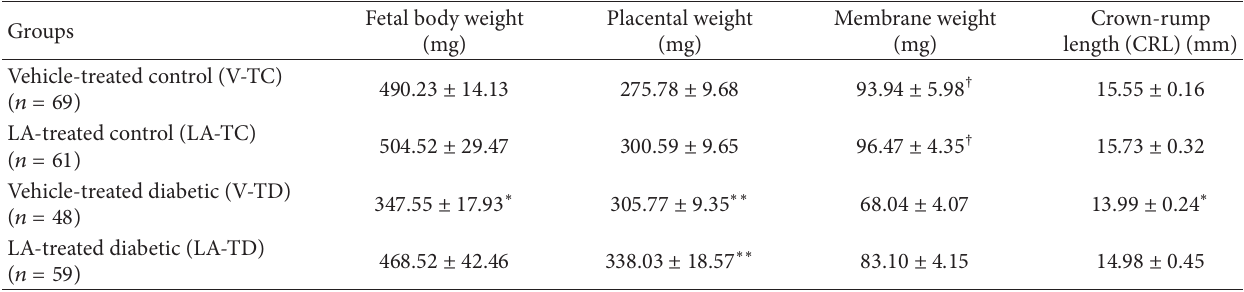
Table 2: The fetal body weight, placental weight, the membrane weight, and the crown-rump length.